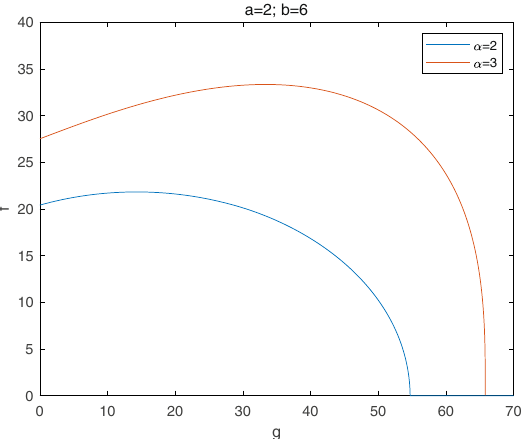
Fig. 2 Tasks where humans replace machines with increasing technological